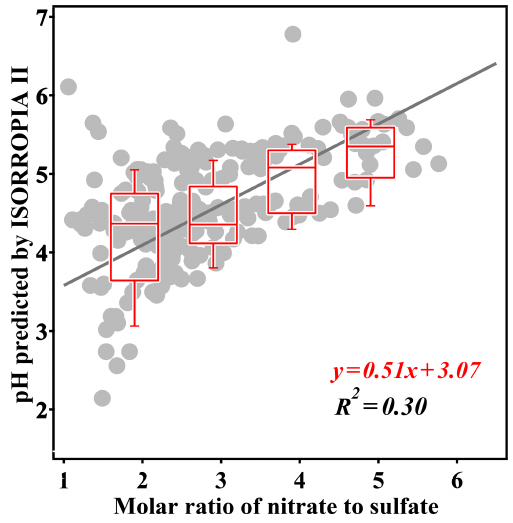
Figure 6. Scatter plot of simulated pH vs. Ratio N-to-S . Linear fitting and the correlation coefficient are given. The box plot denotes the data points classified by four different ranges of the Ratio N-to-S : 0– 2, 2–3, 3–4, and 4–6. Only the data corresponding to the pollution categories and with sufficient aerosol liquid water (above 5µgm − 3 ) are chosen, and the data during Chinese New Year are